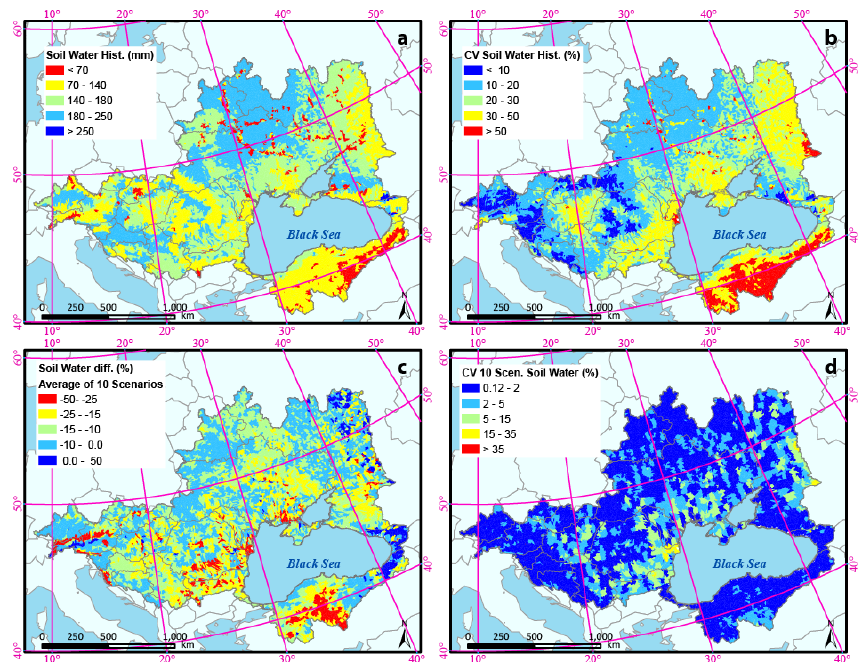
Figure 8. Spatial distribution of green water storage (soil water) in the Black Sea Catchment: ( a ) long-term historical average (1973–2006); ( b ) coefficient of variation (temporal variation) of the green water storage (1973–2006); ( c ) percent deviation of future green water storage (2020–2050) from the historic (1973–2006); ( d ) coefficient of variation of average soil moisture among the 10 scenarios.